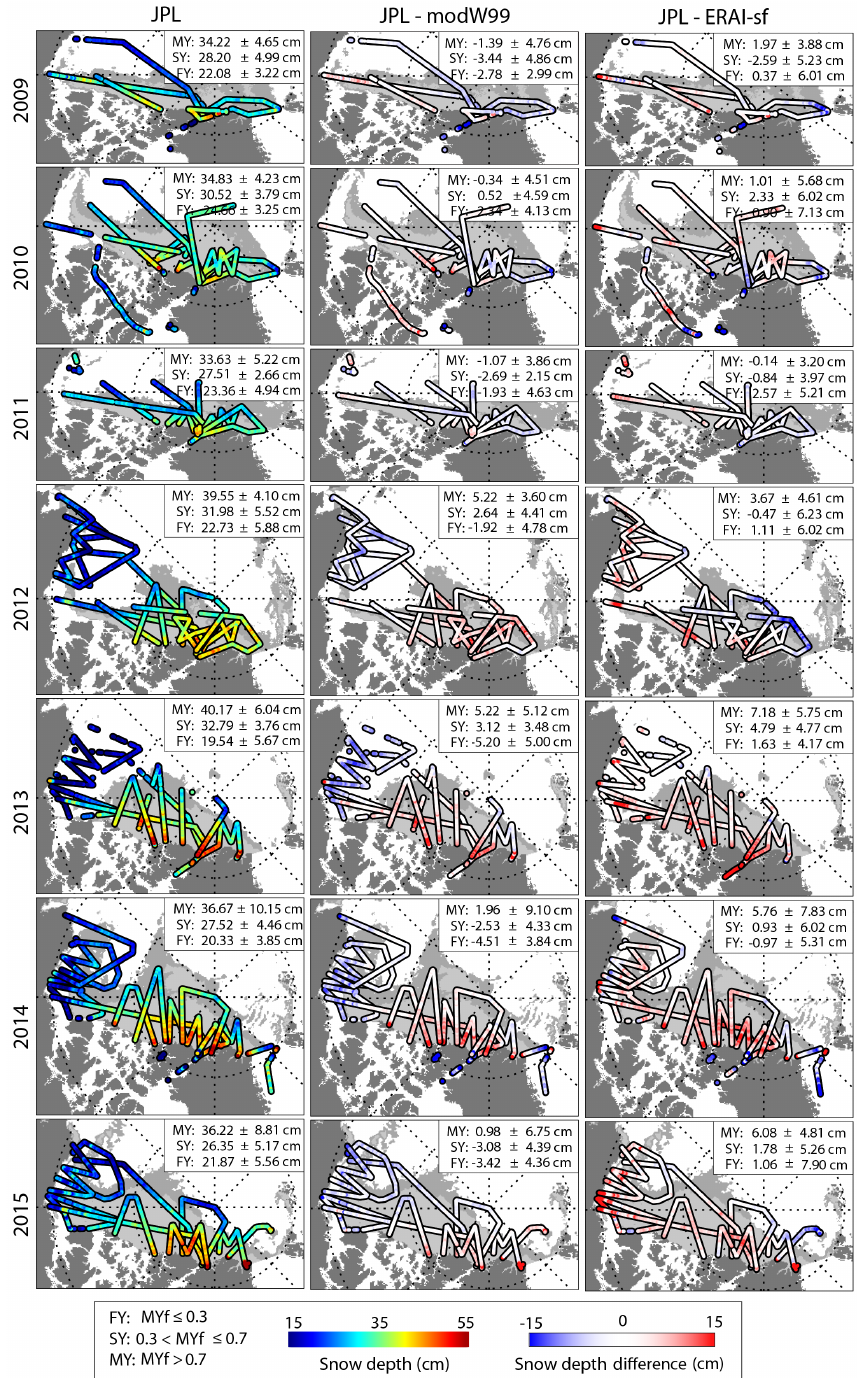
Figure 15. Comparison of JPL snow depth retrievals with ERAI-sf and